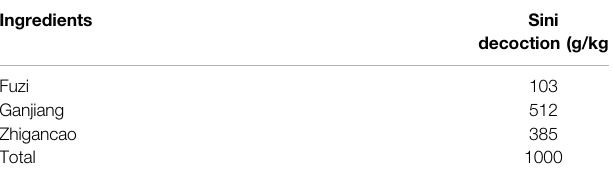
TABLE 1 | Ingredient composition (g/kg) of Sini Decoction.